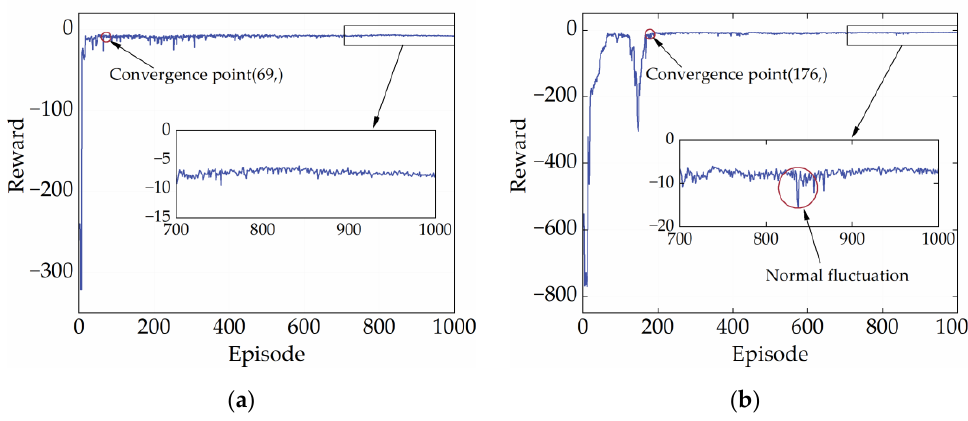
Figure 7. Reward curves under different driving cycles. ( a ) CHTC-B; ( b ) WVUCITY.